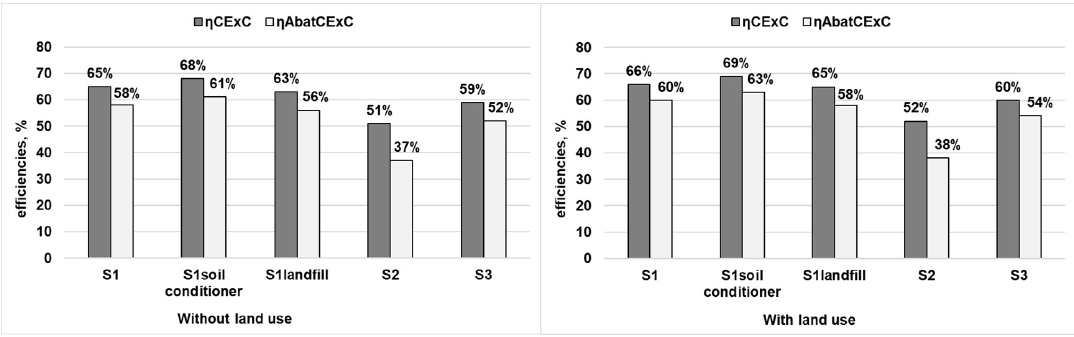
Figure 6. Cumulative exergy consumption (CExC) efficiency and AbatCExC efficiency of the considered systems.